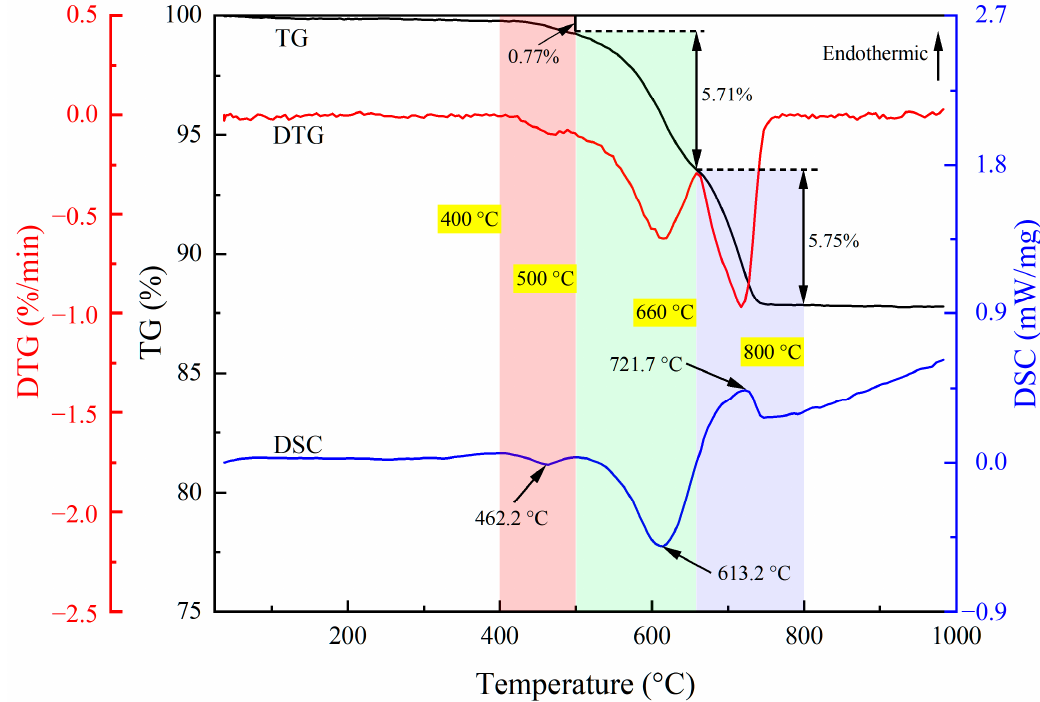
Figure 3. TG, DTG, and DSC cures of the raw ore under air atmosphere (10 K/min).